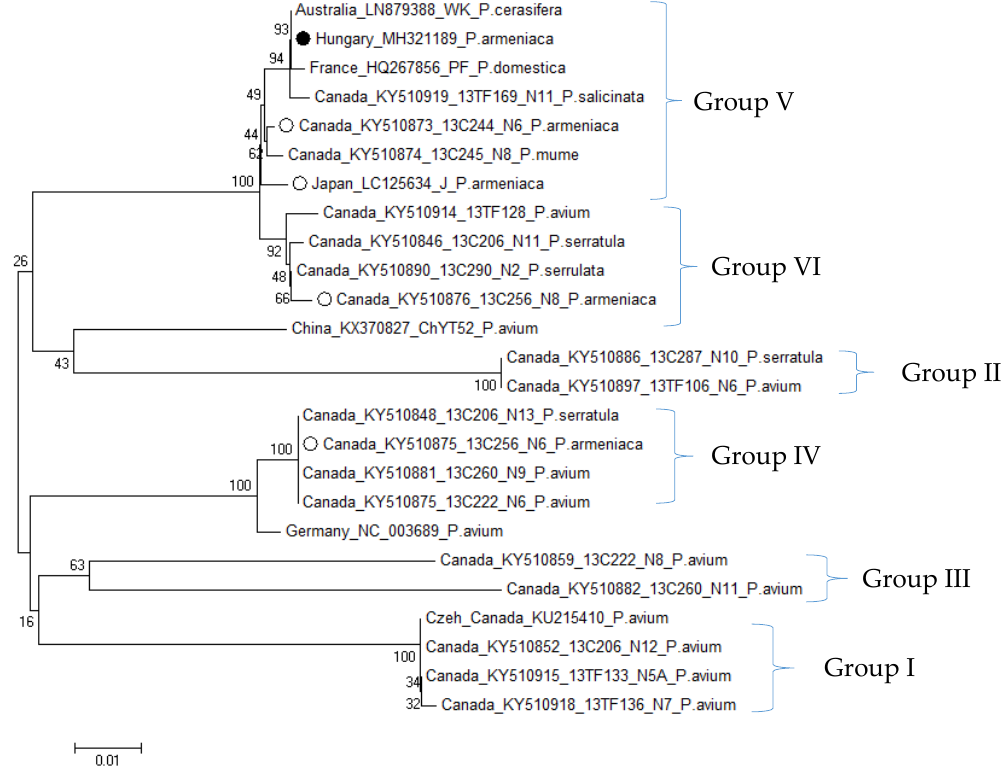
Figure 3. Phylogenetic analysis of movement protein coding sequences of CVA. • -Sequences from